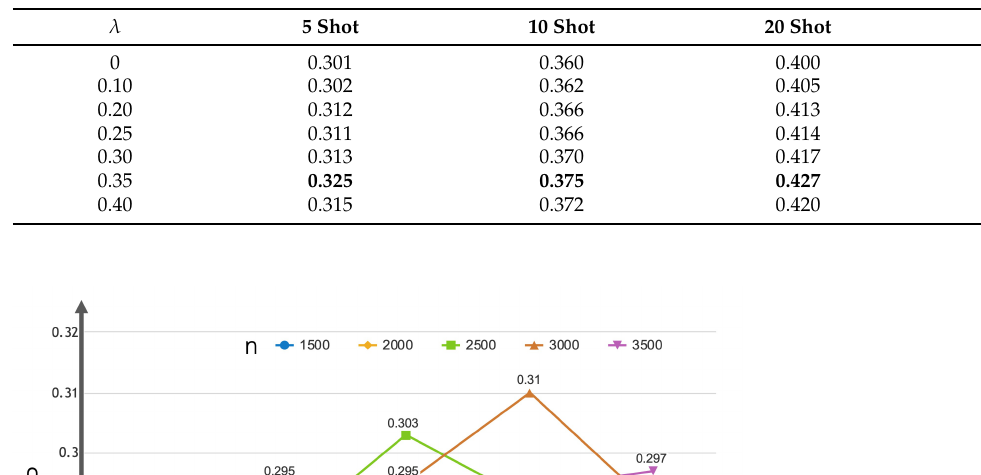
Table 2. Equilibrium parameter λ of L CIR .